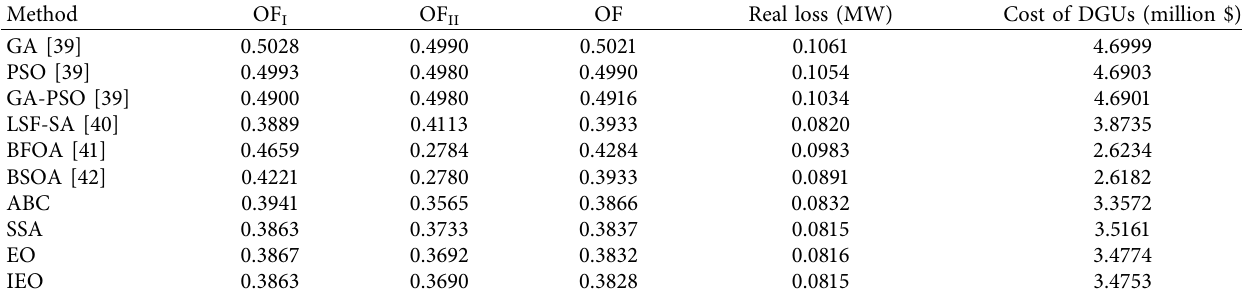
Figure 7: Te ftness values of 50 trial runs in increasing arrangement for the IEEE 33-bus system. Table 4: Te comparison of the objective function values for the IEEE 33-bus system.